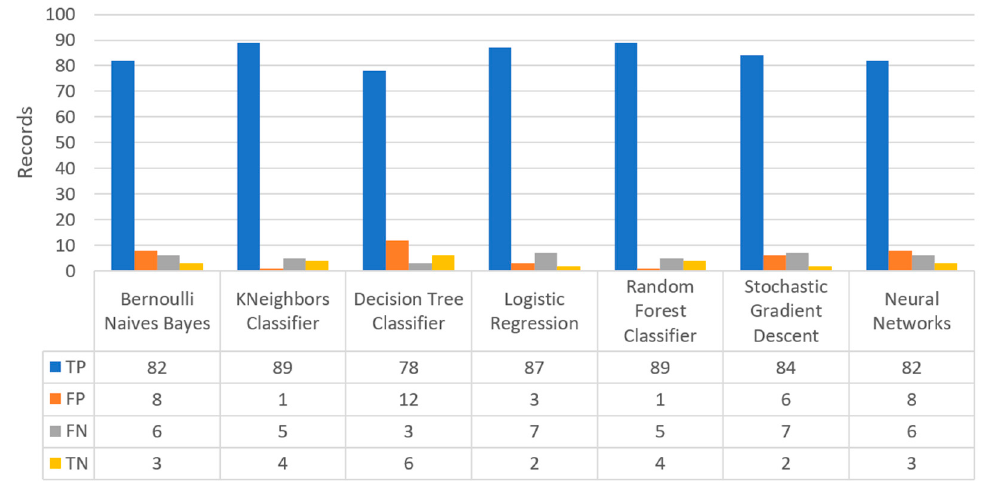
Figure 25. Confusion matrix of prediction results for COVID-19 use case.